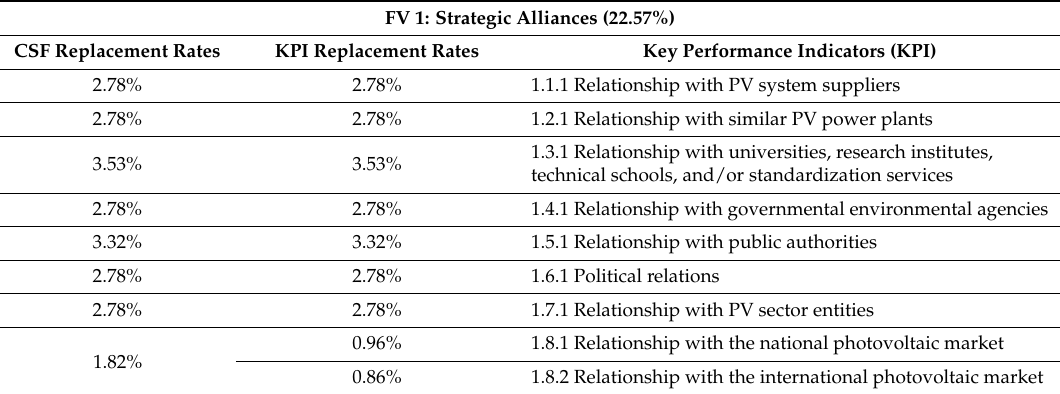
Table 3. Substitution rates for FV CSF 1.